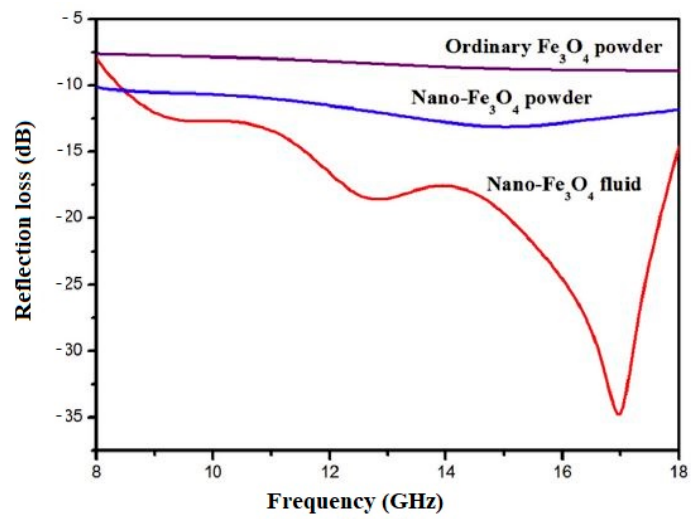
Figure 19. Reflection loss versus frequency for the cement composite containing various amounts of nano-Fe 3 O 4 magnetic fluid (Reprinted with permission from [94]. Copyright 2018 Elsevier).